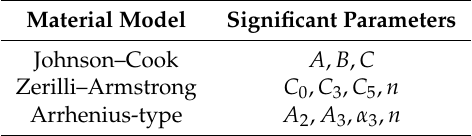
Table 3. Model parameters accounting for 90% or more of the Quantity of Interest (QoI) variance.